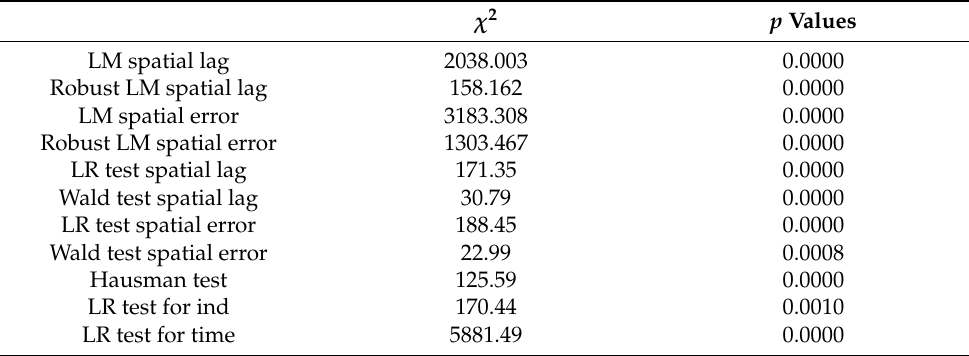
Table 3. Applicability test of spatial panel